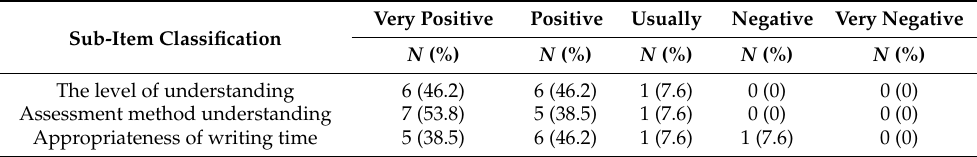
Table 11. Discriminant validity results of utility